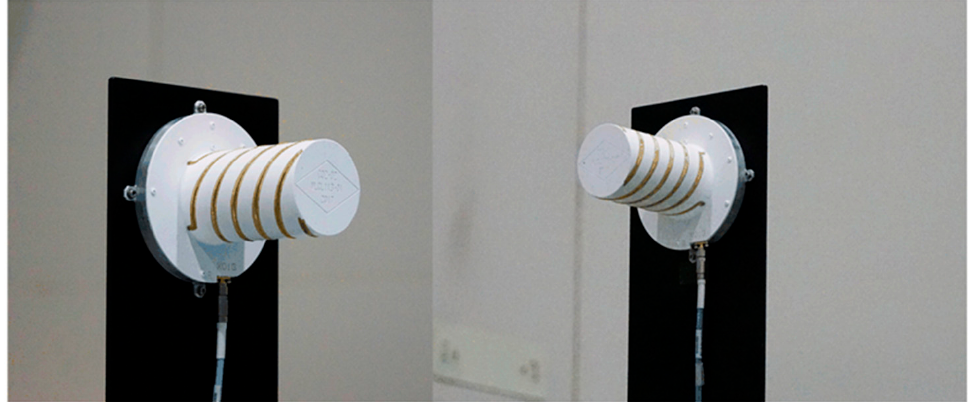
Figure 6. The quadrifilar helix antenna used for synchronization link.